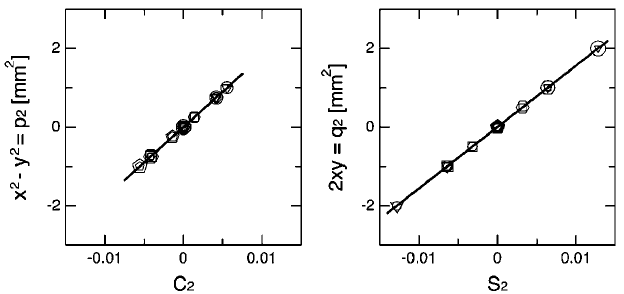
FIG. 11. Relation between p numerically calculated BPM with circular cross